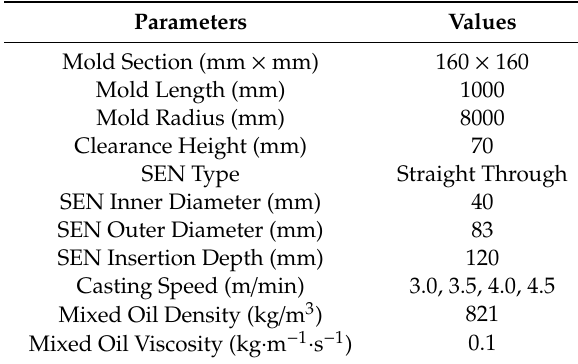
Table 1. Dimensions and parameters. SEN, submerged entry